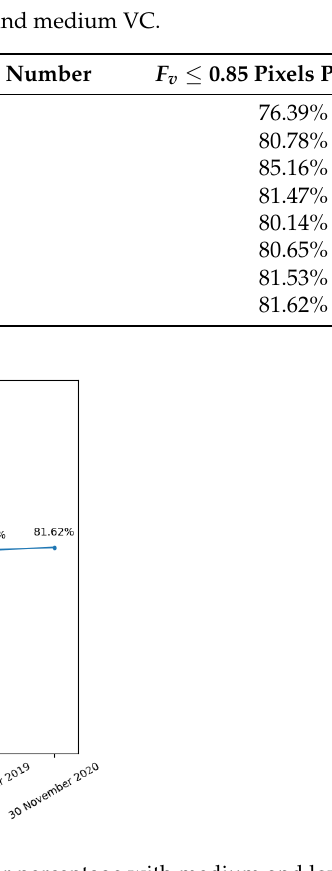
Figure 6. Time series change curve of the pixel number percentage with medium and low VC